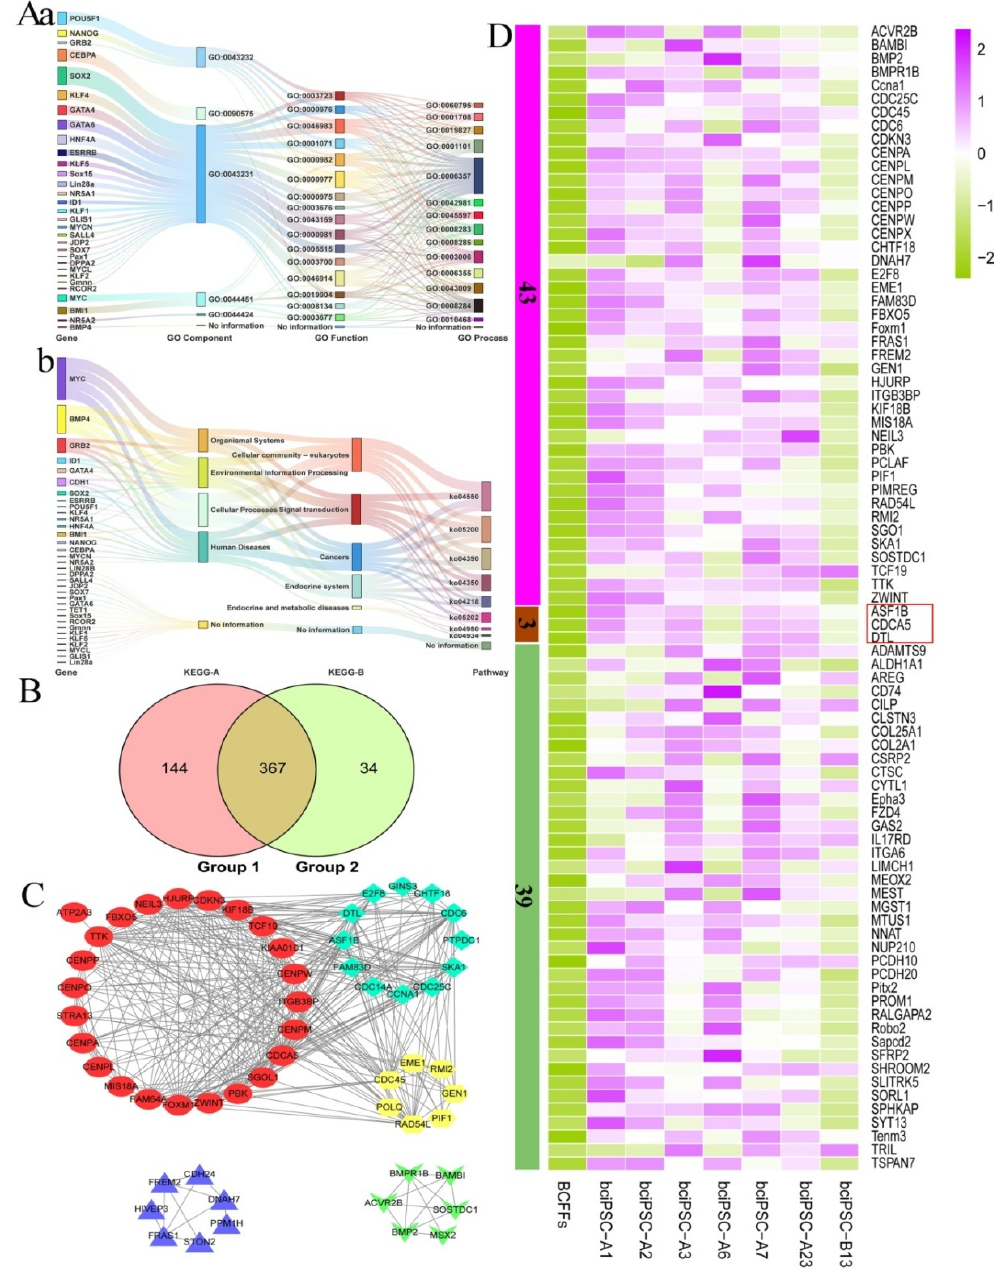
Figure 5. Mining of potentially pluripotency genes of bciPSCs. ( A ) ( a ) the attribution of the 34 induced genes in the GO database is displayed by an alluvial plot, ( b ) the attribution of the 34 induced genes in the KEGG database is displayed by a alluvial plot; ( B ) group 1 includes 511 genes; group 2 includes 401 genes; ( C ) the protein-protein interaction (PPI) network is composed of 56 genes; ( D ) a heat map of 85 genes. It is composed of 46 core genes and 42 supplementary genes, of which three genes are shared.